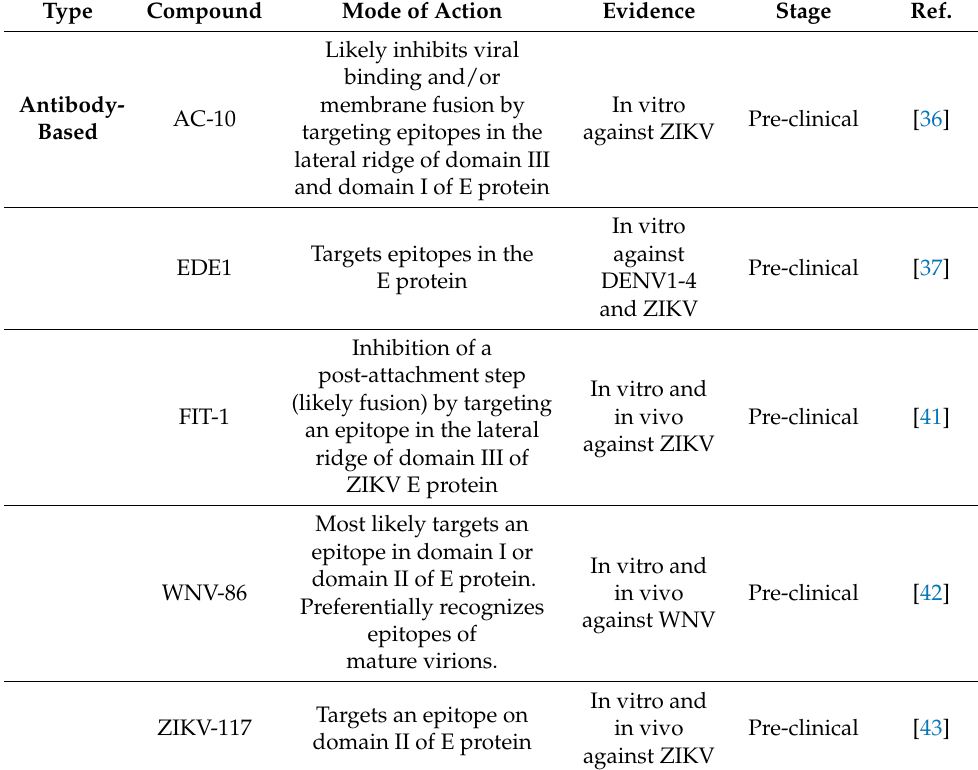
Table 2. Summary of key characteristics of the compounds